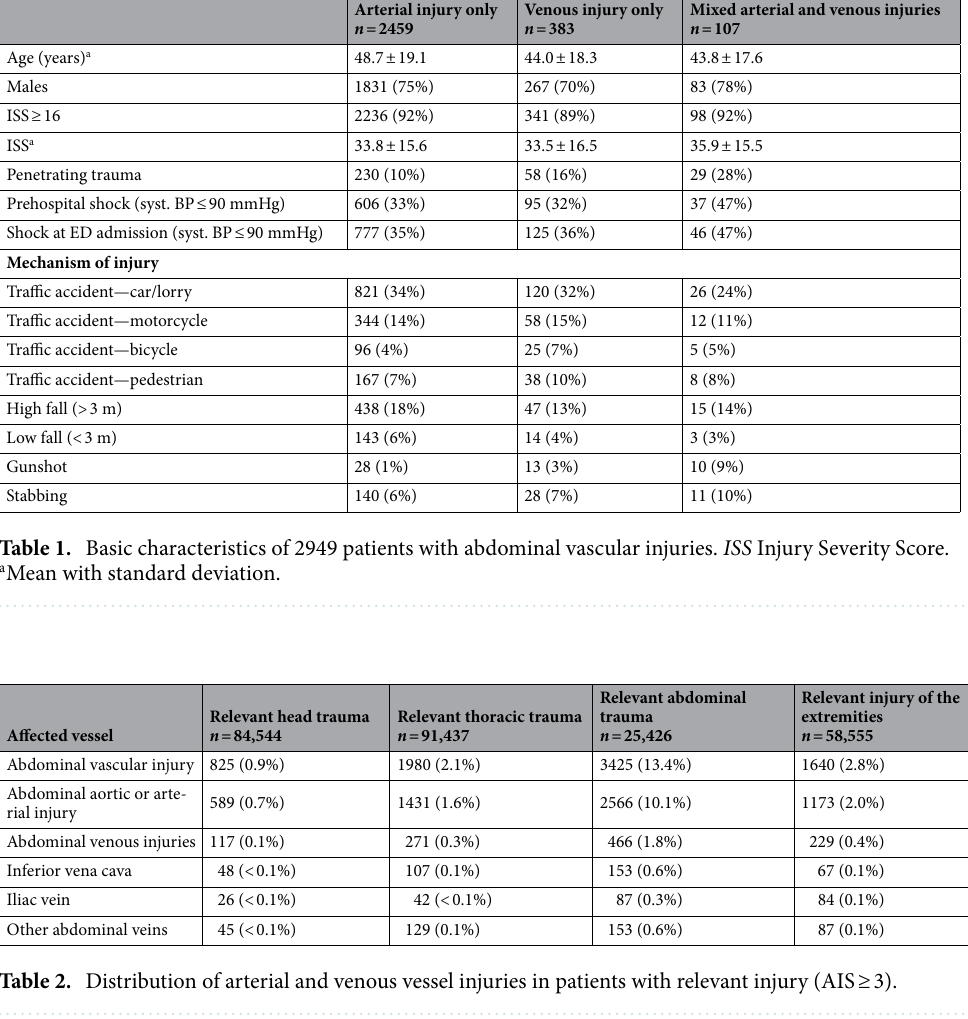
Table 2. Distribution of arterial and venous vessel injuries in patients with relevant injury (AIS ≥ 3).